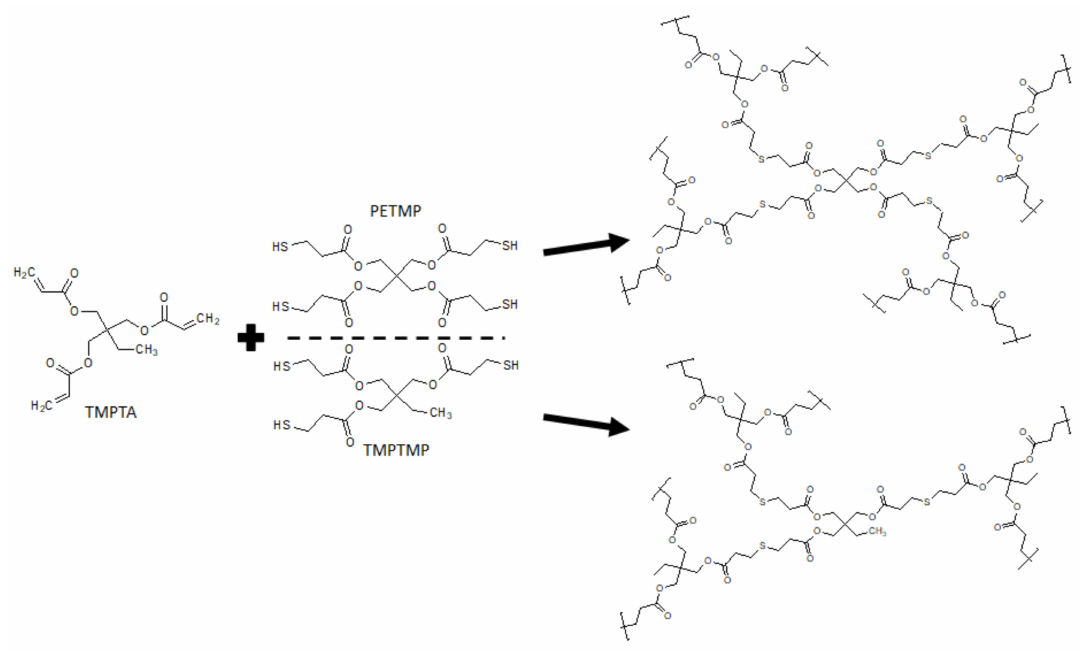
Figure 2. Polymerization scheme of the prepared trithiol- and tetrathiol-based microspheres.